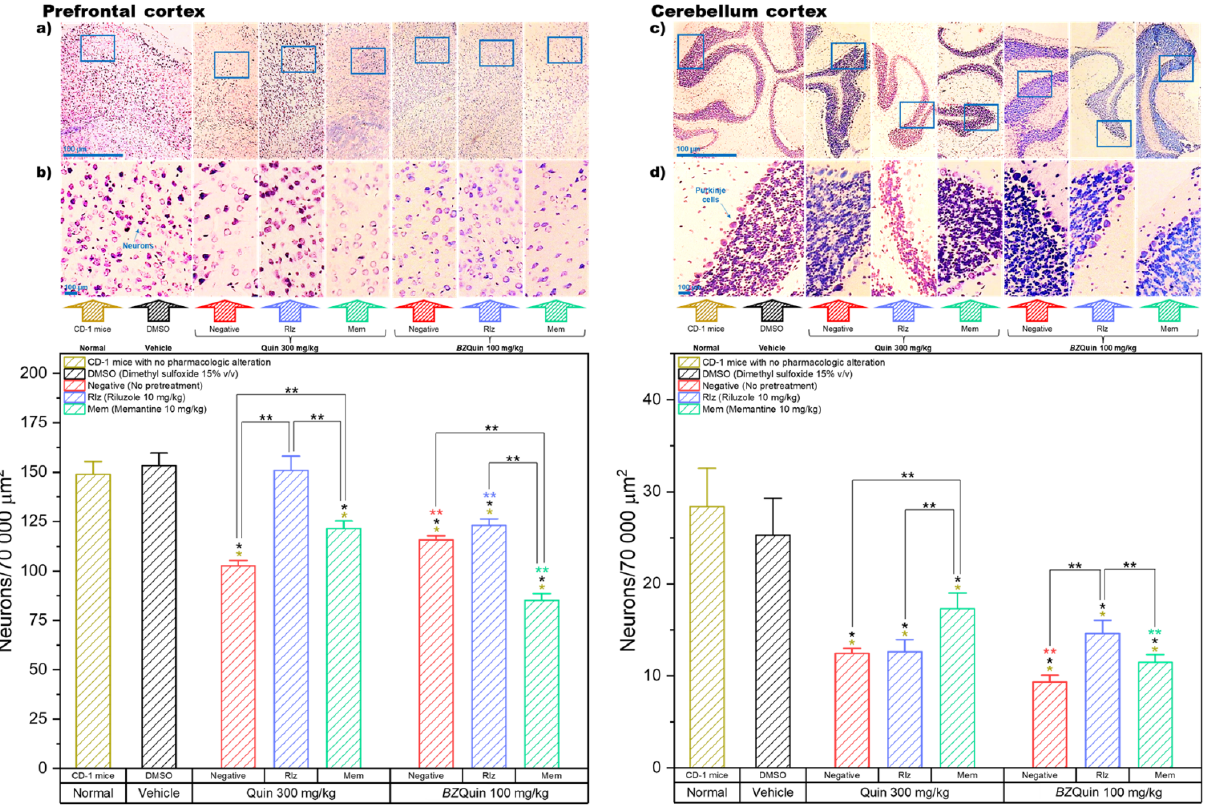
Figure 11. Left. Prefrontal cortex (neuron count): * p < 0.001 compared to the normal group; * p < 0.001 compared to the vehicle group. Neurons/70,000 μ m 2 (pretreatment): Rlz > Negative > Mem, p < 0.001. Neurons/70,000 μ m 2 (stimulating agent) : Quin 300 mg/kg > BZQuin 100 mg/kg, p < 0.001. ** p < 0.001. ** p < 0.01 compared to the negative group with Quin at 300 mg/kg. ** p < 0.001 compared to the Rlz group with Quin at 300 mg/kg. ** p < 0.001 compared to the Mem group with Quin at 300 mg/kg. Micrographs at magnifications of ( a ) 4× and ( b ) 20×. Right. Cerebellum cortex (neuron count, specifically Purkinje cells): * p < 0.001 compared to the normal group; * p < 0.05 compared to the vehicle group. Neurons/70,000 μ m 2 (pretreatment): Mem > Rlz > negative, p < 0.001. Neurons/70,000 μ m 2 (stimulating agent) : Quin 300 mg/kg > BZQuin 100 mg/kg, p < 0.001. ** p < 0.05. ** p < 0.01 compared to the negative group with Quin at 300 mg/kg. ** p < 0.001 compared to the Mem group with Quin at 300 mg/kg. Micrographs at magnifications of ( c ) 4× and ( d ) 20×.